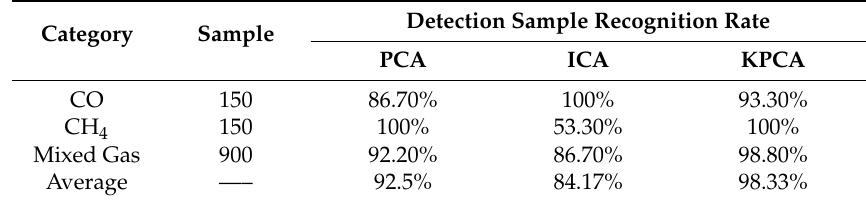
Table 3. Recognition results corresponding to PCA, ICA and KPCA.